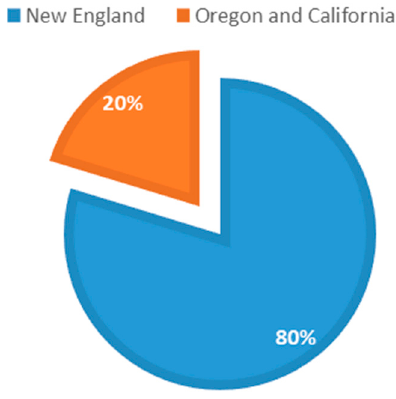
Figure 1. Distribution of survey respondents between New England and the Klamath ecoregion of northern California and southwestern Oregon (total N = 153).